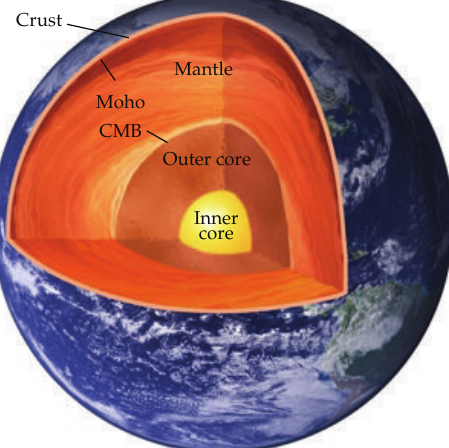
Figure 1: Schematic of Earth’s internal structure. Adapted from